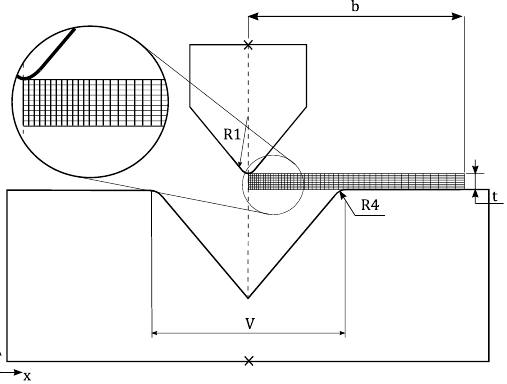
Figure 10. Geometry and variables defined for problem (b) FE model. Table 2. Mechanical properties and Swift law hardening parameters of selected materials used in problem